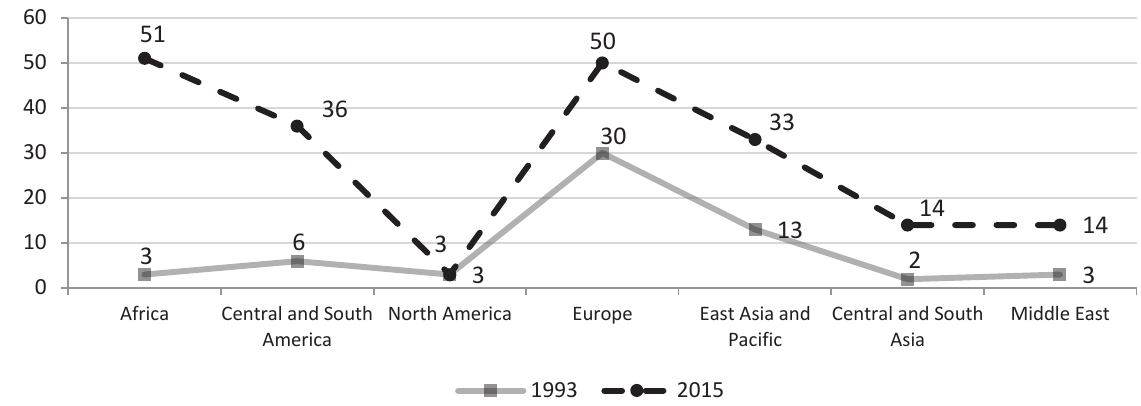
Figure 2. The number of countries, which apply ISO 9001 certification in a particular region in 1993 and in